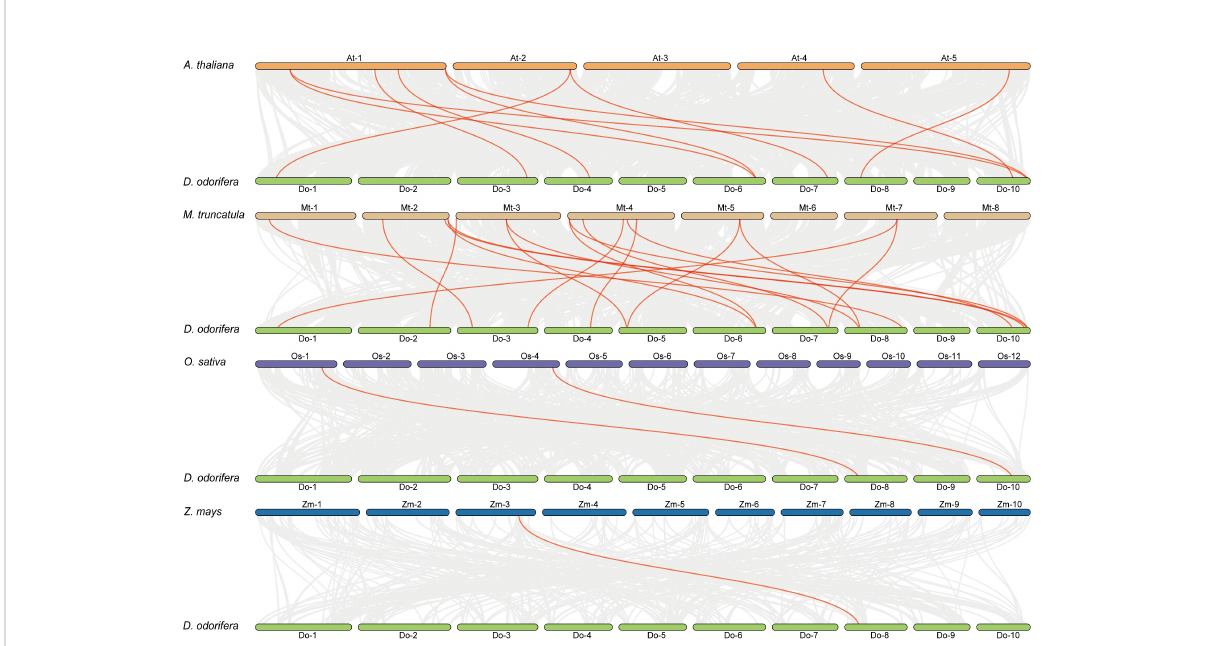
FIGURE 4 Syntenic relationships of DoCCR genes with other CCR genes in four representative plant species. Gray lines in the background indicated the collinear blocks within D. odorifera and other plant genomes. Red lines in highlight indicated the syntenic CCR gene